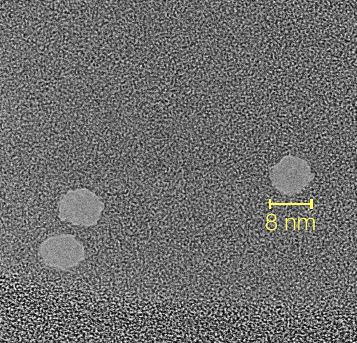
Figure 5. (Color online) TEM image of a CNM after 176 keV Xe 40 + irradiation. Individual nanopores can be observed as a result of single ion impacts